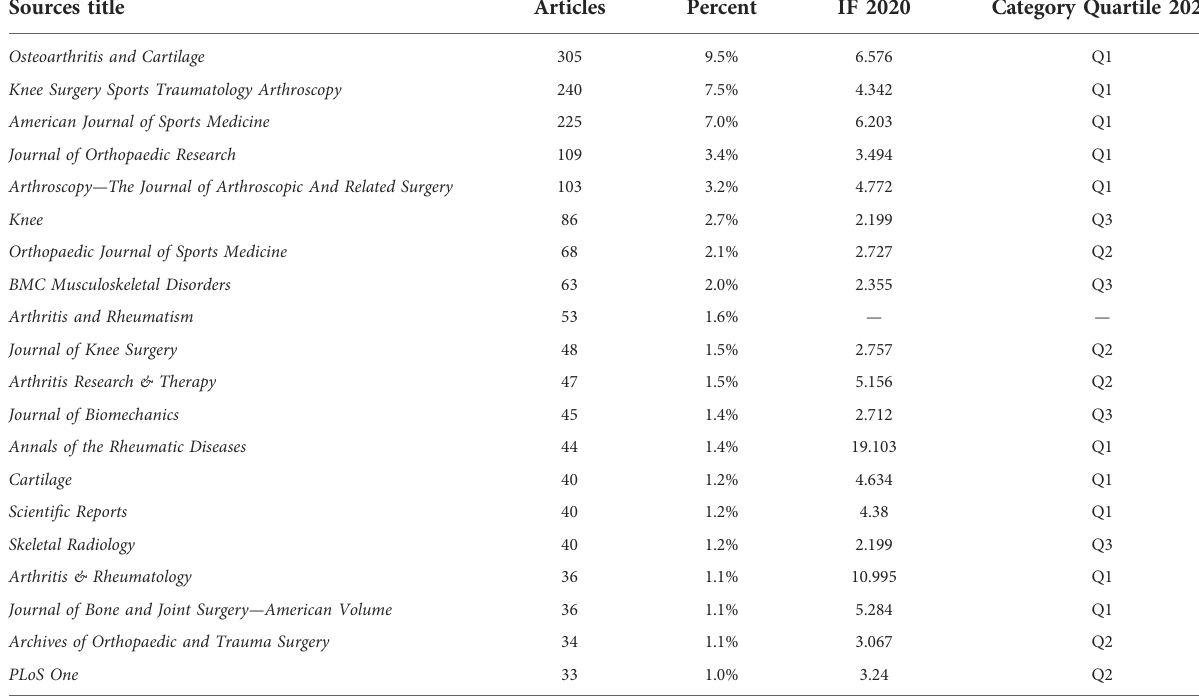
TABLE 2 Top 20 journals with most articles in KOA with meniscus research.